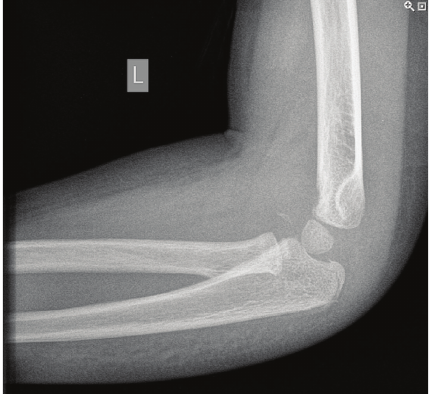
Figure 3: Repeat lateral radiograph of the same elbow twelve days later. The olecranon fracture is more defined.